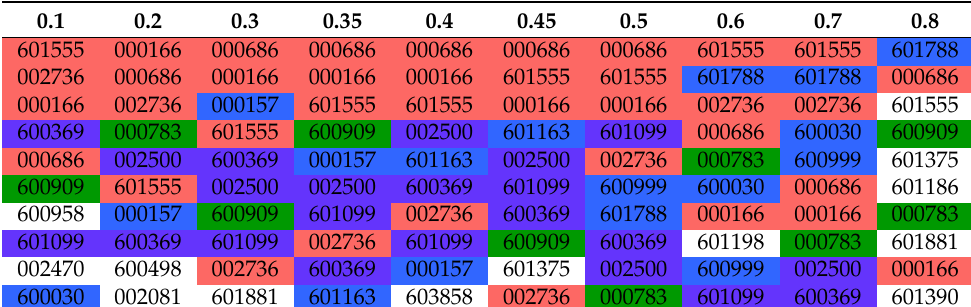
Table 2. Degree centrality in the Pearson stock